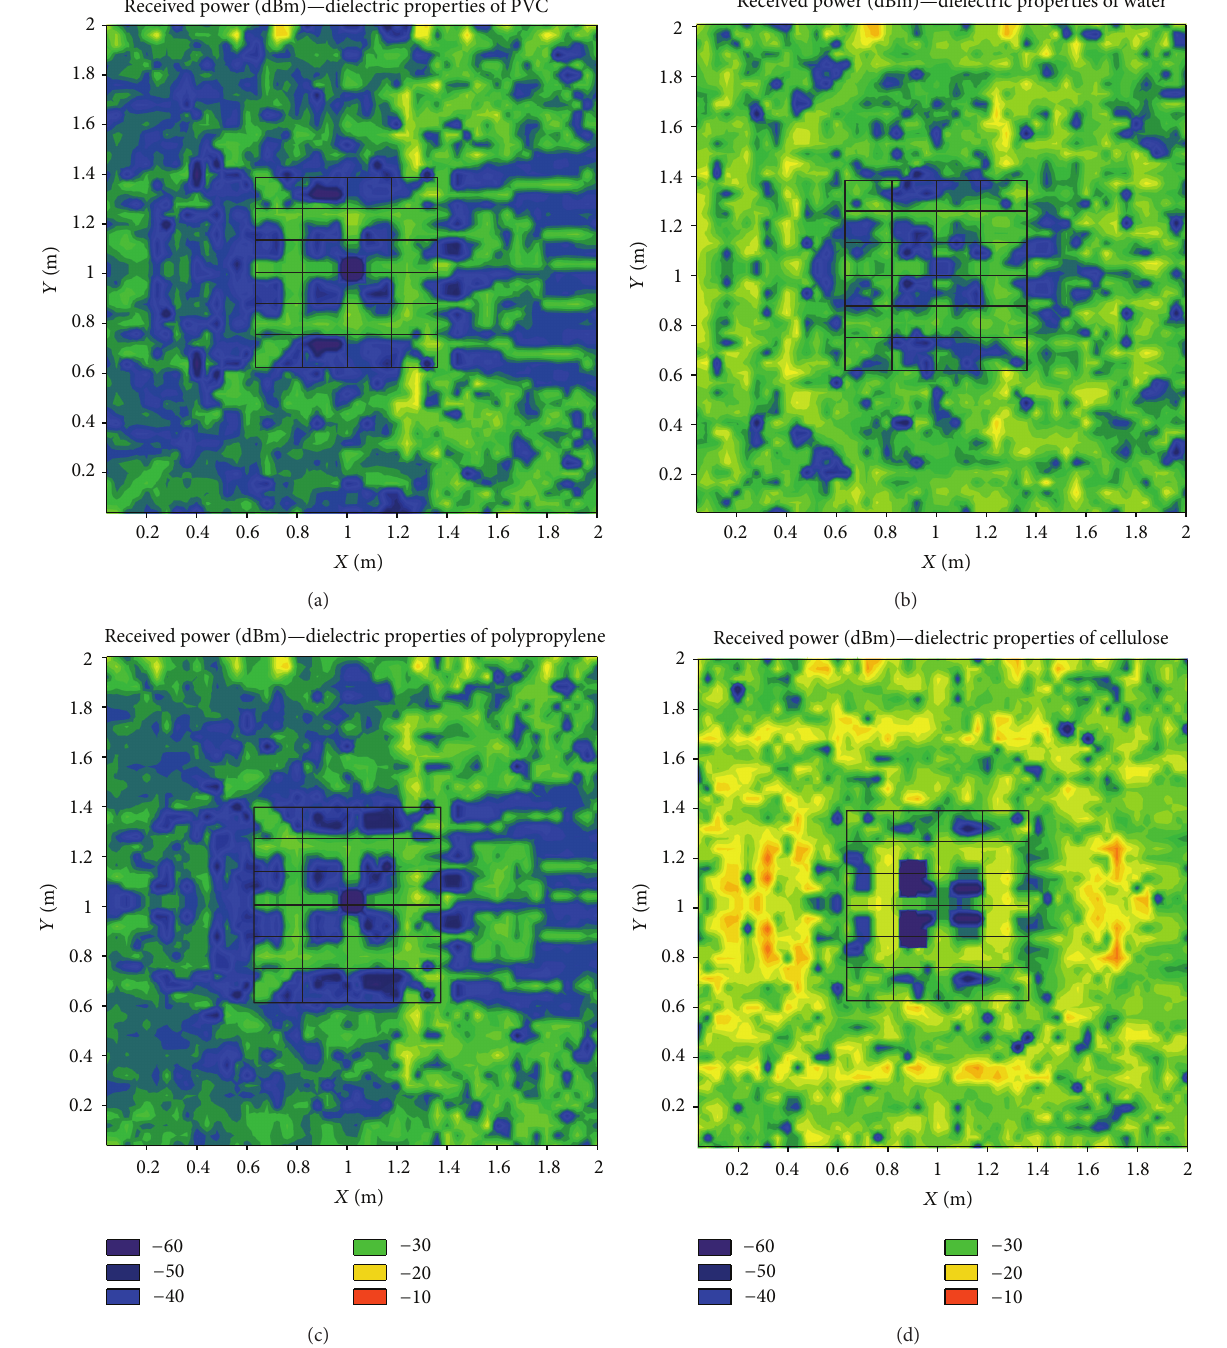
Figure 2: Received power (dBm) for the first row of boxes in the pallet for different material products considered. (a) Polyvinyl chloride (PVC). (b) Drinking water. (c) Polypropylene. (d)